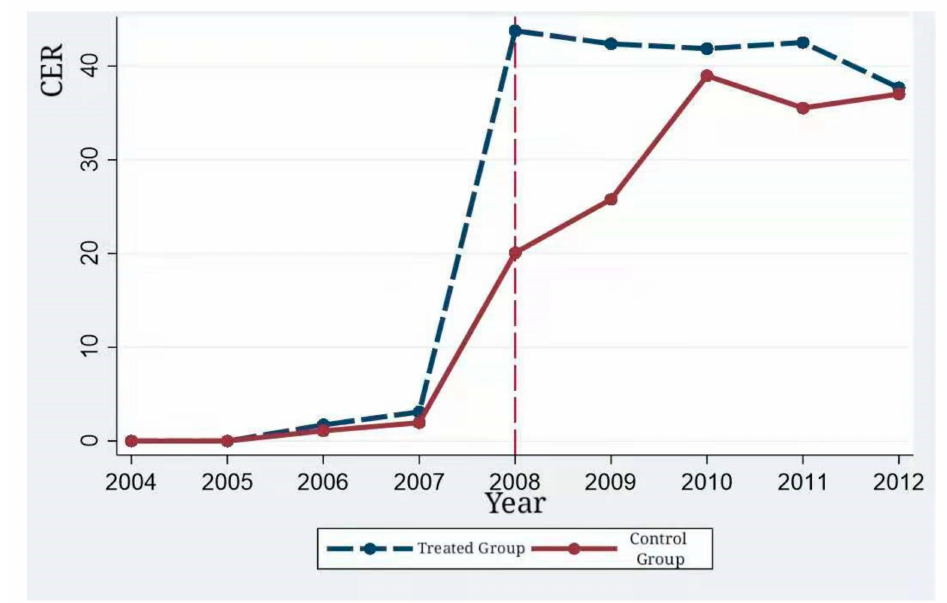
Figure 1. Growth trends of the CER score.